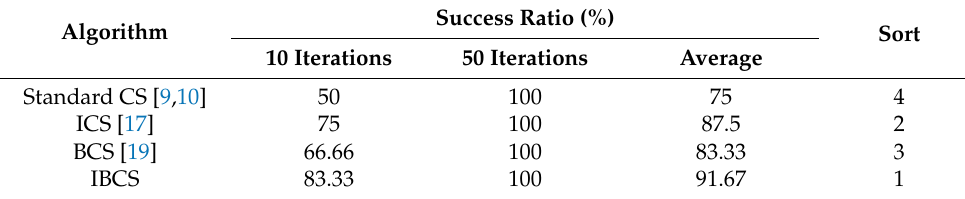
Table 5. Test results of four optimization algorithms on the Ra single-objective optimization.